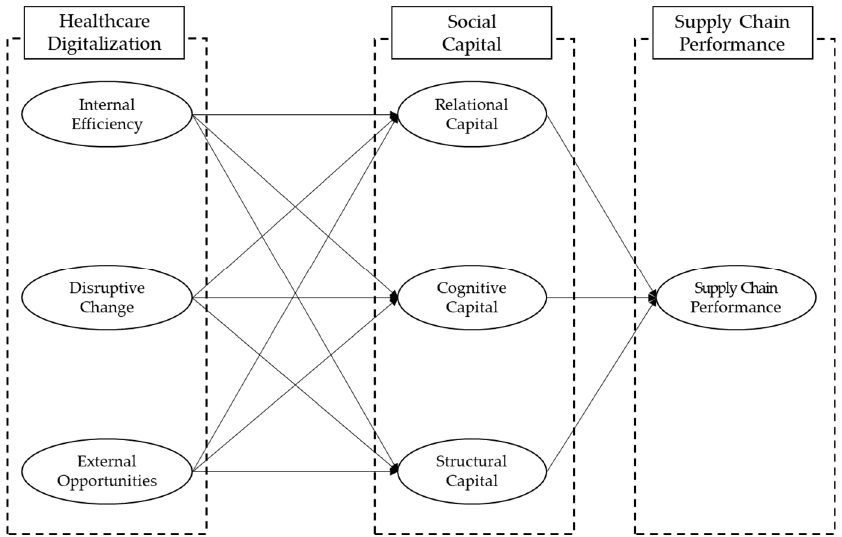
Figure 1. The study